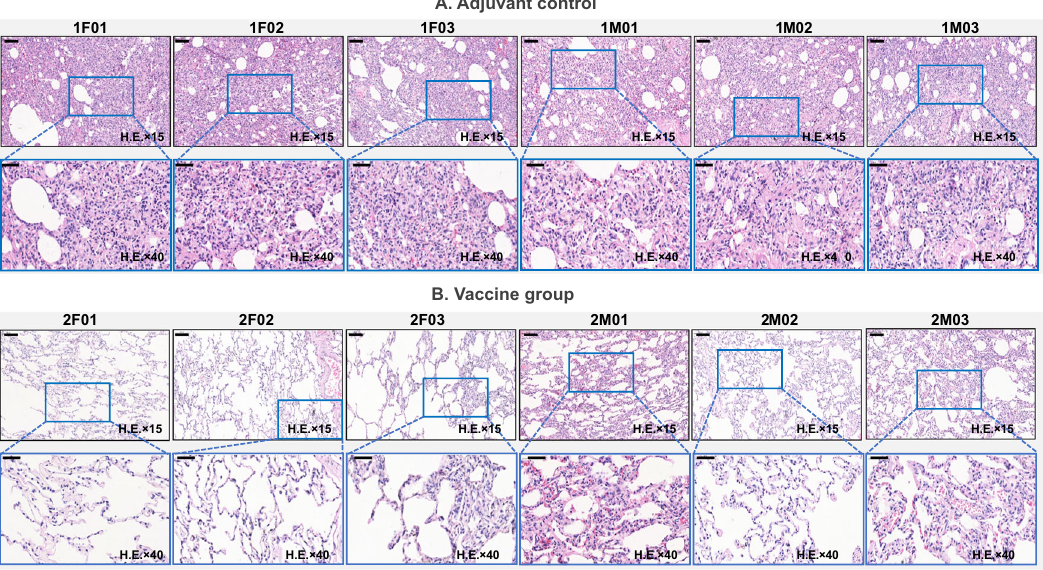
Fig. 10 The lung pathology of rhesus macaques infected with 10 5 TCID 50 of prototype SASR-CoV-2. A Adjuvant group and B vaccine group. Note: Microscope images were taken at 15 and 40 magni fi cation (H.E × 15 and H.E × 40), the scale bar in H.E × 15 is 100 µm, in H.E × 40 is 50